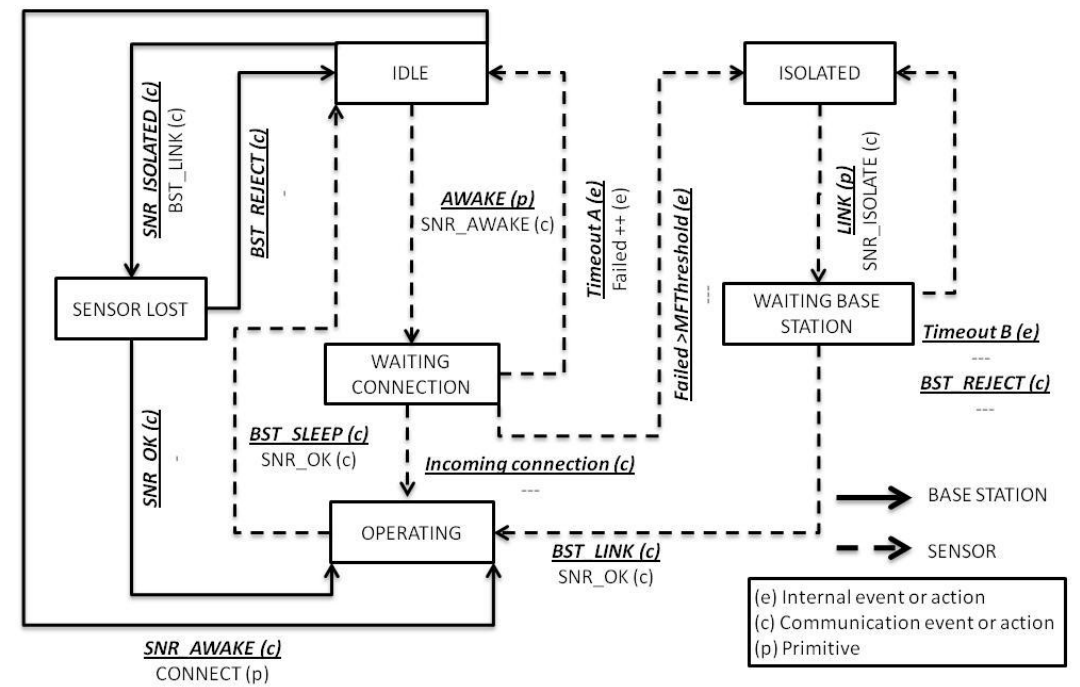
Figure 2. Protocol state